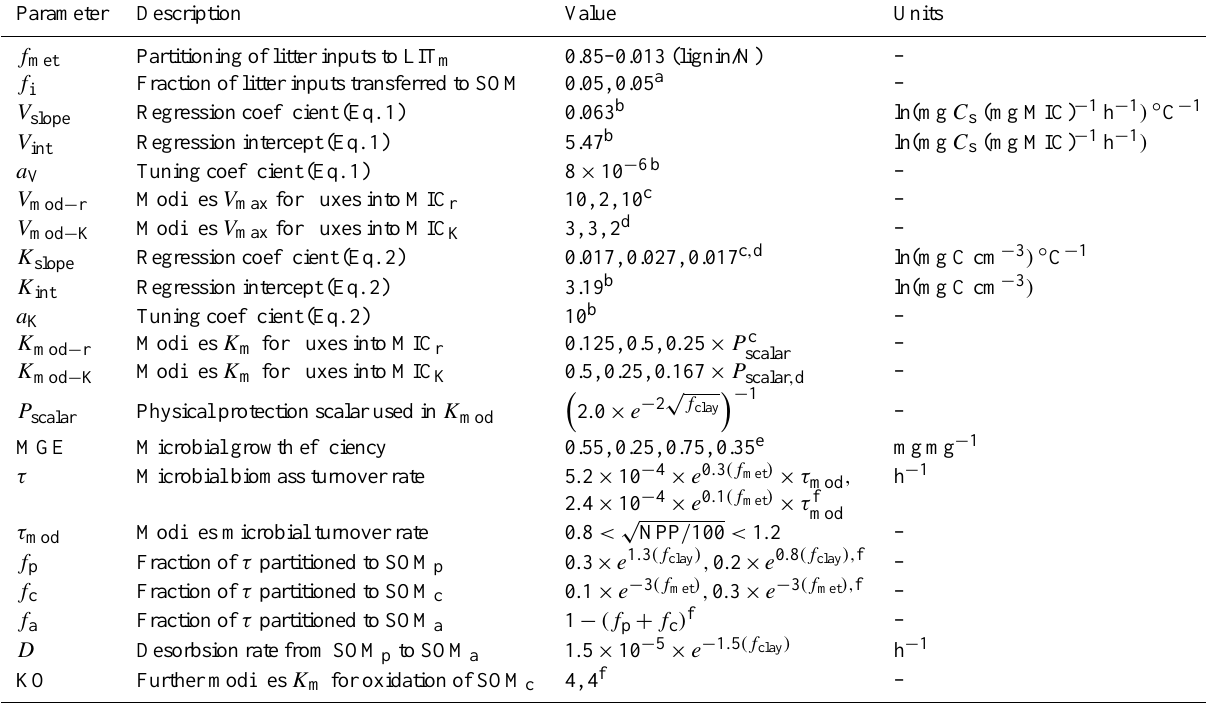
Table B1. MIMICS parameters, values, and units used for LIDET